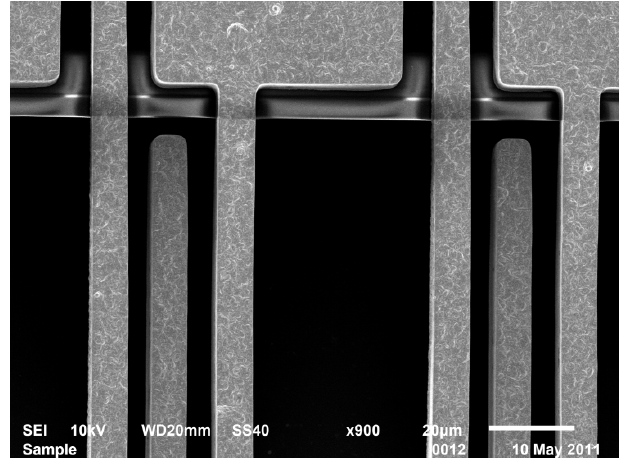
Figure 11. Downward bending can be observed along the sensing comb fingers that are used for stress